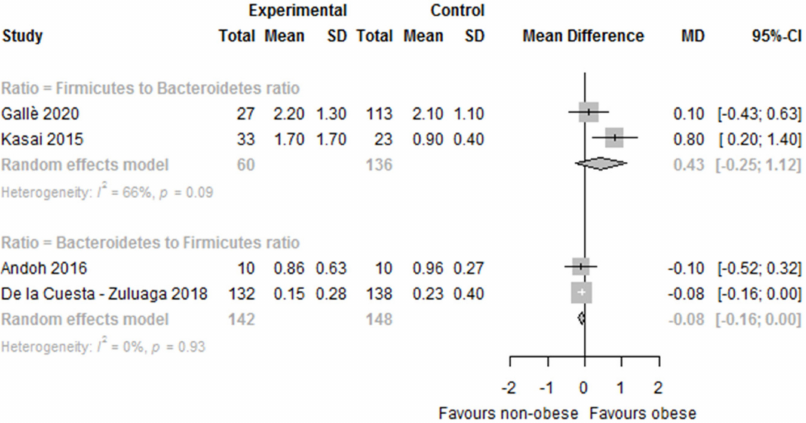
Figure 7. Forest plot of the differences in the Firmicutes to Bacteroidetes ratio between obese and non-obese. Study references: Andoh et al. [17], De la Cuesta—Zuluaga et al. [41], Gall è et al. [45], and Kasai et al.